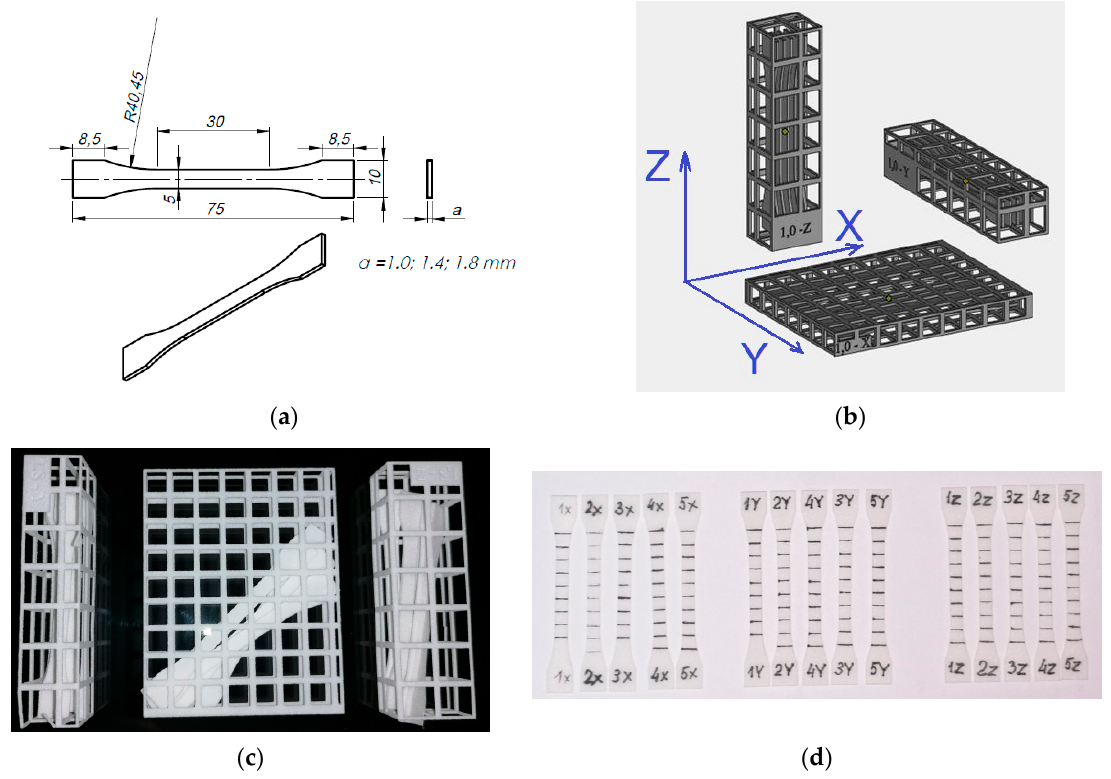
Figure 1. Samples built in three directions; ( a ) sample dimensions, ( b ) orientation on the build tray, ( c )